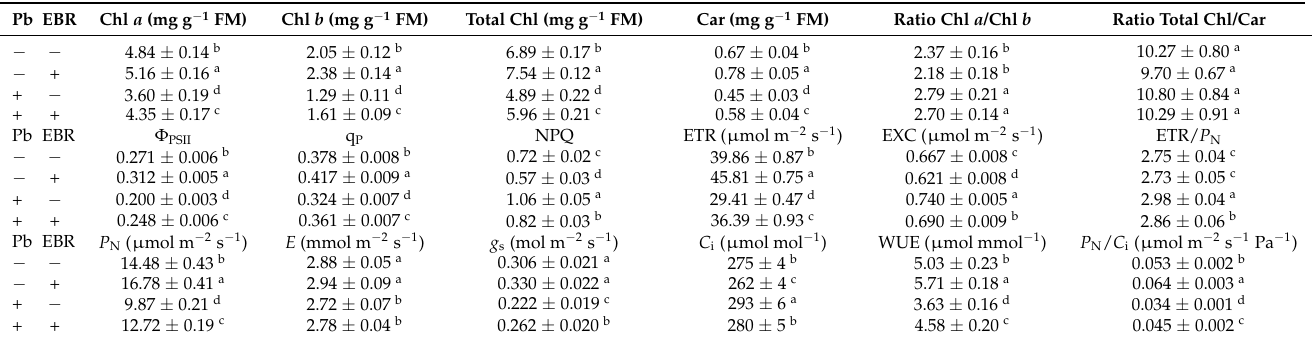
Table 4. Photosynthetic pigments, chlorophyll fluorescence, gas exchange in tomato plants treated with EBR and subjected to Pb toxicity.